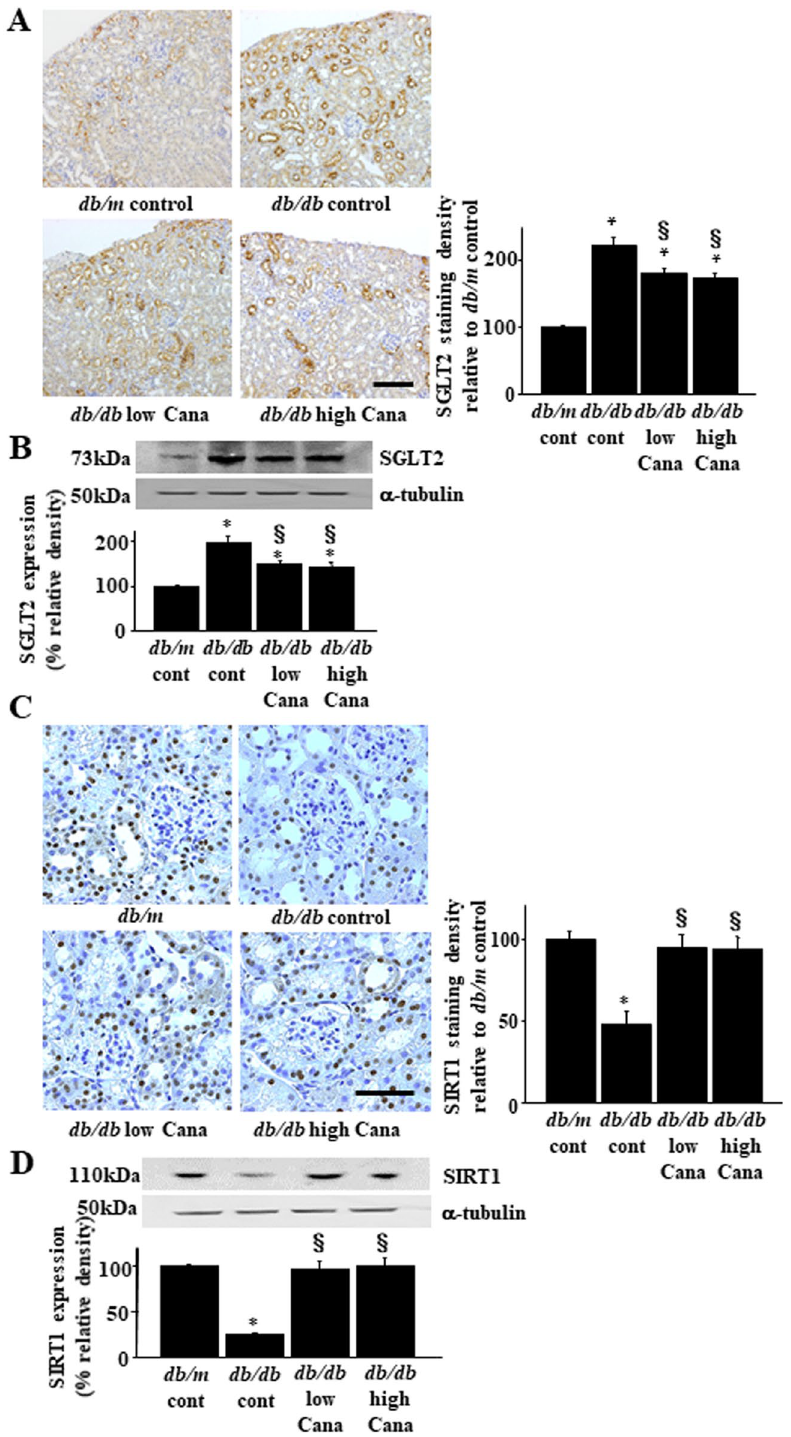
Figure 2. Effect of Cana on SGLT2 and SIRT1 expression in db / db mice. ( A ) Immunohistochemical analysis using a SGLT2-specific antibody. Representative kidney sections are shown for each group of mice. Quantitation of relative density is shown in the bar graph in the right panel. Scale bar, 100 µ m. * P < 0.05 vs. db / m control and § P < 0.05 vs. db / db control (n = 8 mice/group) ( B ) The upper panel shows representative immunoblotting analysis of SGLT2 expression. The Bar graph in the lower panel indicates quantification of SGLT2 levels. Protein expression was normalized to that of α -tubulin. Relative protein levels are shown as the fold-change to the db / m (control) group. * P < 0.05 vs. db / m control and § P < 0.05 vs. db / db control. The results are representative of four independent experiments. ( C ) Immunohistochemical analysis using a SIRT1-specific antibody. Representative kidney sections are shown for each group of mice. Quantitation of relative density is shown in the bar graph. Scale bar, 50 µ m. * P < 0.05 vs. db / m control and § P < 0.05 vs. db / db control ( n = 8 mice/group). ( D ) The upper panel shows representative immunoblotting analysis of SIRT1 expression. The bar graph in the lower